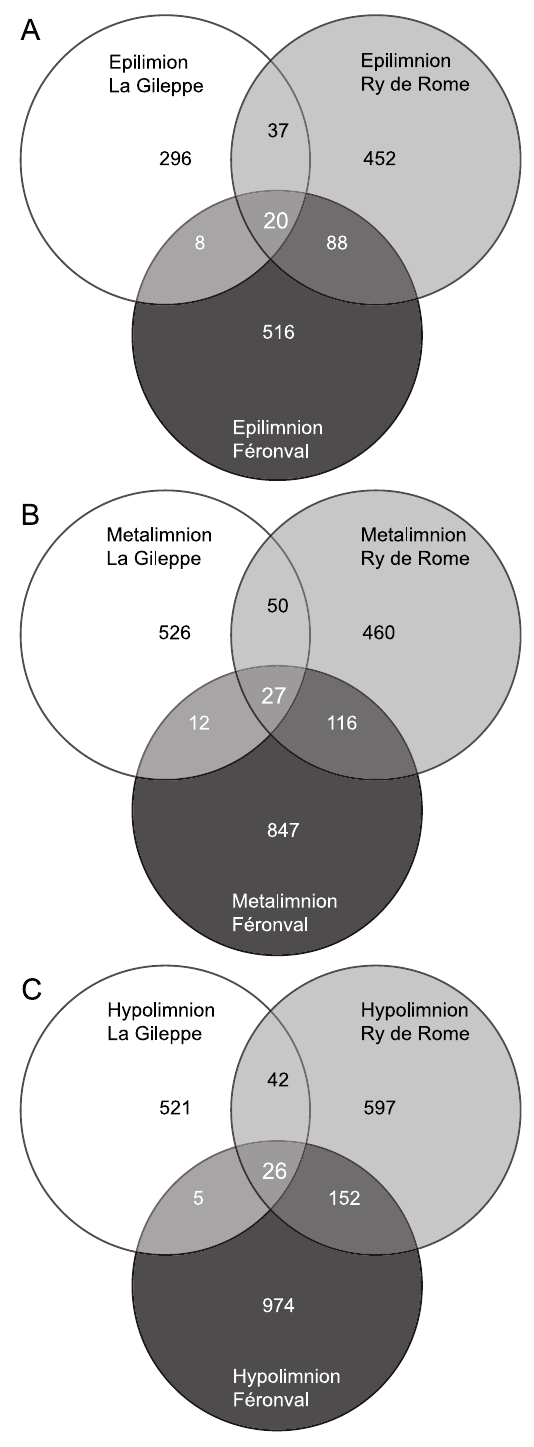
Fig. 5. Shared bacterial community. Venn diagrams highlighting shared OTUs for each analysed water compartment ( A , epilimnion; B , metalimion; and C , hypolimnion) and reservoir (i.e., La Gileppe, Ry de Rome and